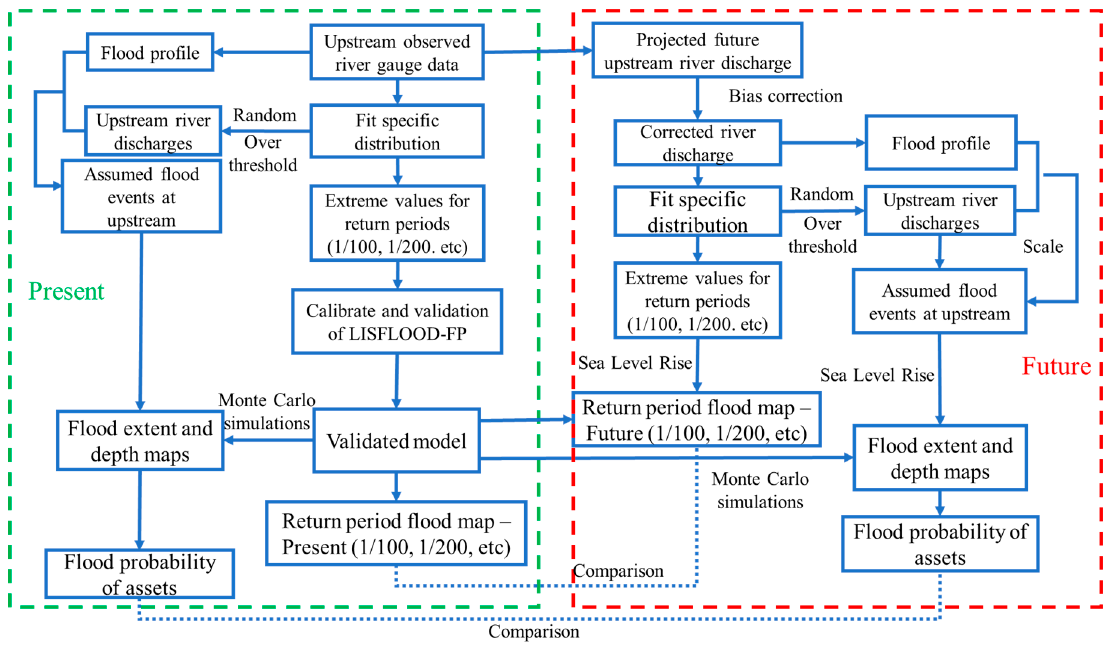
Figure 8. The flow chart of hydraulic modelling in the small town case to consider both present (green) and future (red) scenarios with sea level rises and climate change.